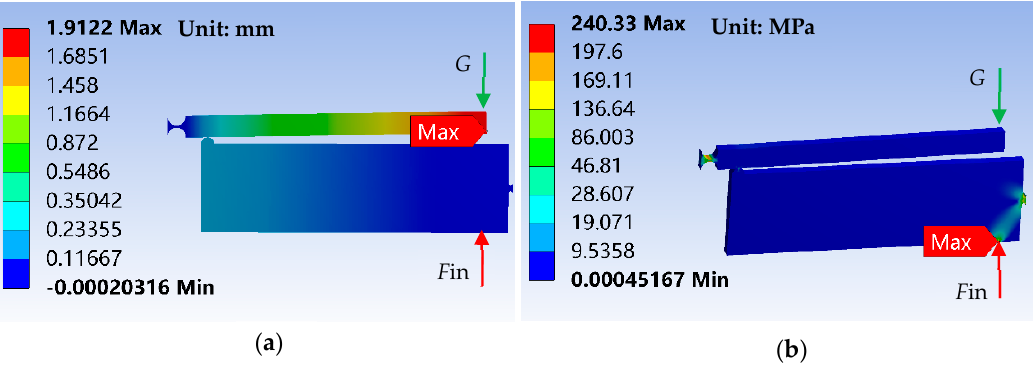
Figure 6. Deformation in the y direction and Von-Mises stress levels of a two-stage flexural hinge lever-type mechanisms based on optimal parameters under input force F in = 850 N. ( a ) The deformation in the y direction of two-stage lever mechanisms, and ( b ) the Von-Mises stress levels of two-stage lever mechanisms.